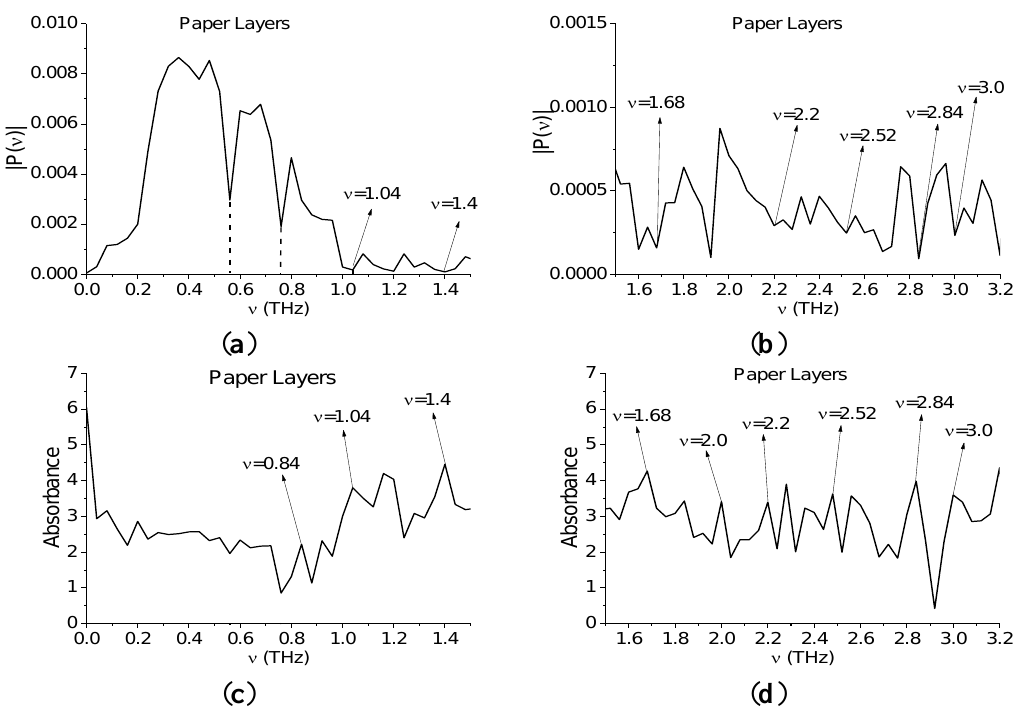
Figure 8. Fourier spectrum ( a , b ) and absorbance ( c , d ) of the main pulse of the signal Paper Layers in the frequency range ν = [0, 1.5] THz (a,c); [1.5, 3.2] THz